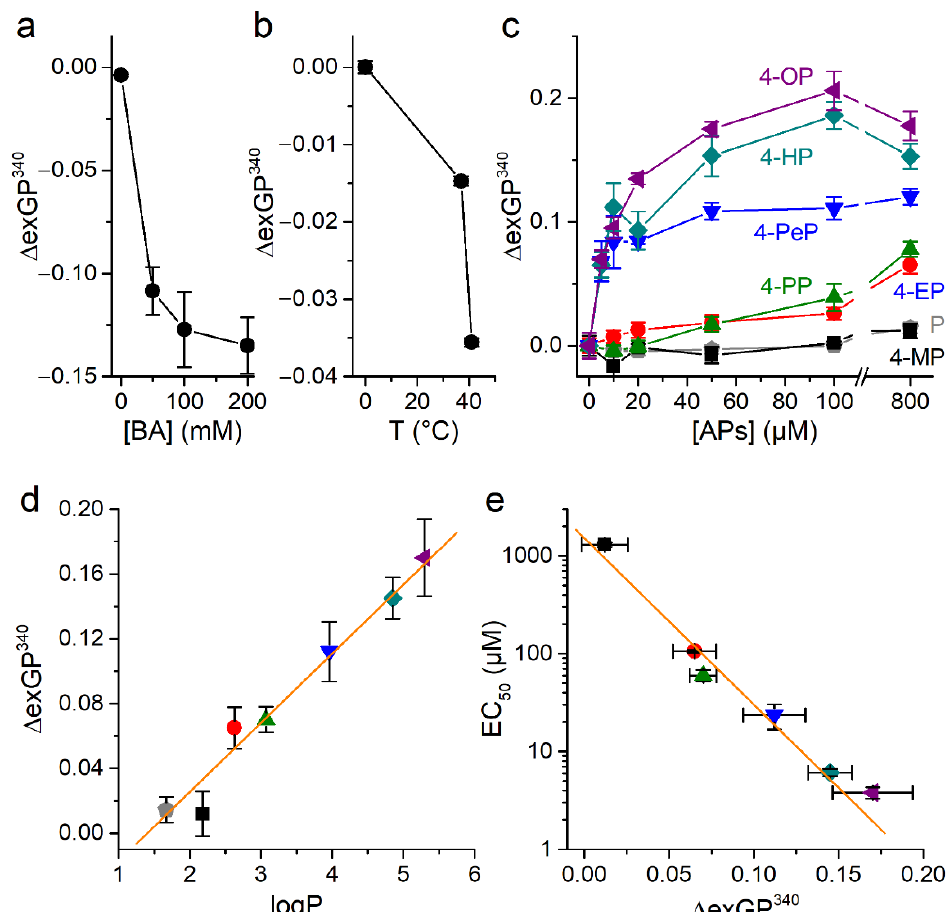
Figure 7. Phenol and alkylphenols induce changes of membrane fluidity. ( a ) Changes in exGP 340 induced by the membrane fluidizing compound benzyl alcohol (BA, 0–200 mM). ( b ) Changes in exGP 340 induced by changing temperature. ( c ) Concentration-dependent changes in exGP 340 induced by of phenol and APs. All experiments were conducted in CHO-TRPA1 cells stained with 1.5 µM Laurdan and measured at T = 37 ◦ C. The data is shown as mean ± s.e.m. from at least three experiments performed in triplicate. ( d ) Relationship between the ∆ exGP 340 attributed to the rise of membrane order and the partition coefficient of phenol and APs (800 µ M). The orange line represents the fit with a linear function with a slope of 0.043 ± 0.003 (Pearson’s correlation coefficient 0.98, R 2 = 0.97). ( e ) Relationship between APs EC 50 value for TRPA1 activation and change in exGP 340 induced by application of the APs (800 µ M). The orange line represents the fit with a linear function with a slope of − 17.0 ± 1.3 µ M (Pearson’s correlation coefficient − 0.99, R 2 = 0.98).